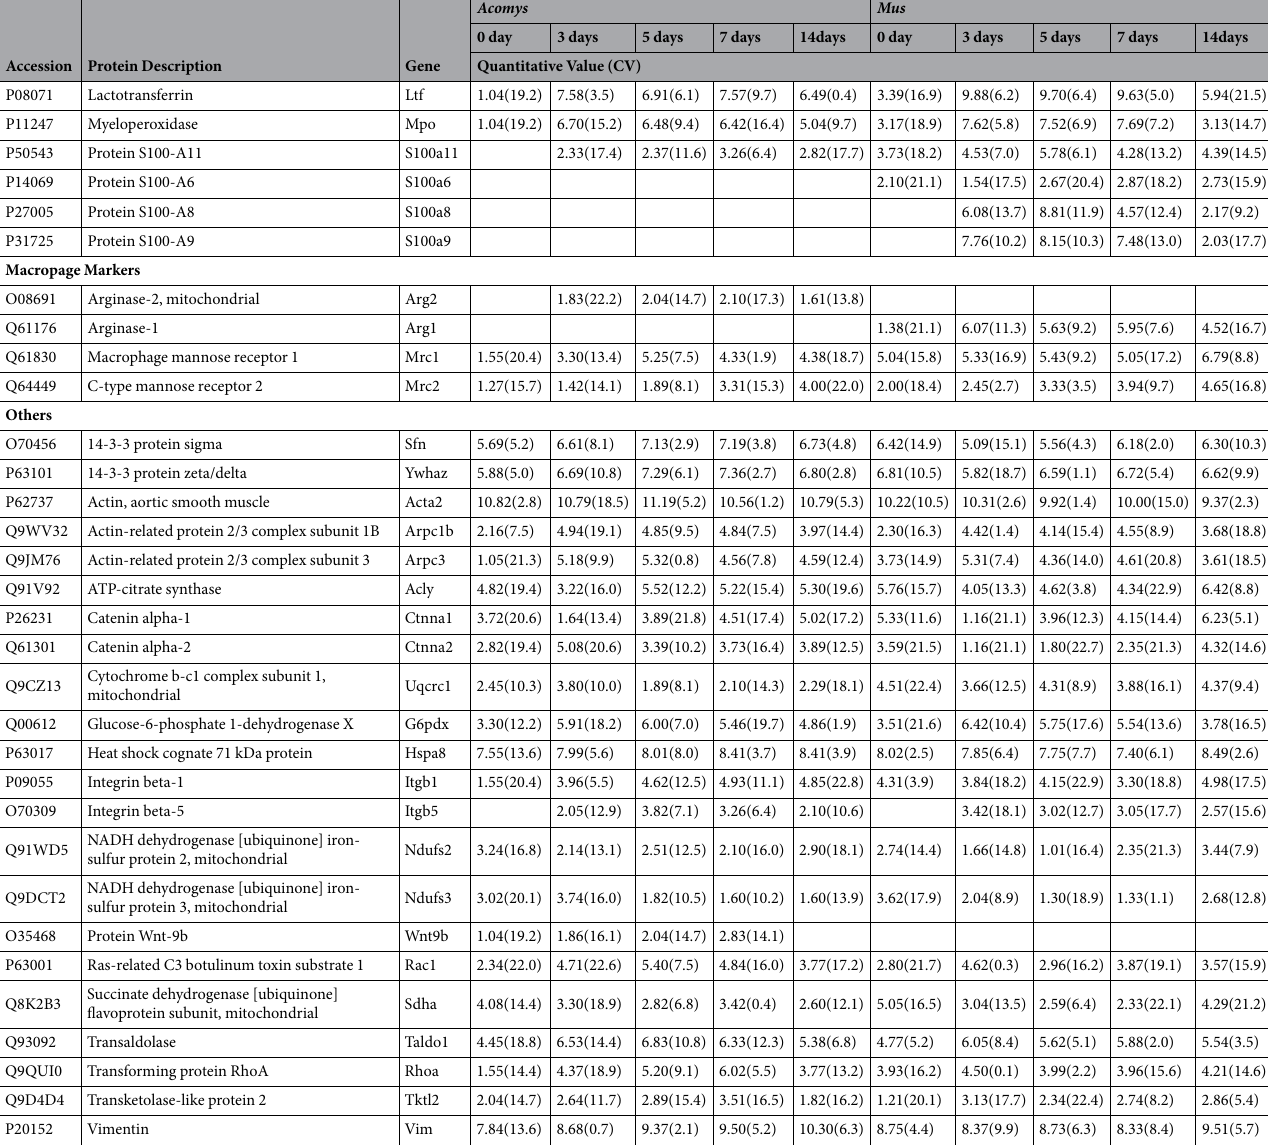
Table 1. Proteins identified from Acomys and Mus associated with wound healing over 14 days. * Quantitative value is log2(protein area/ total protein area) X 10 6